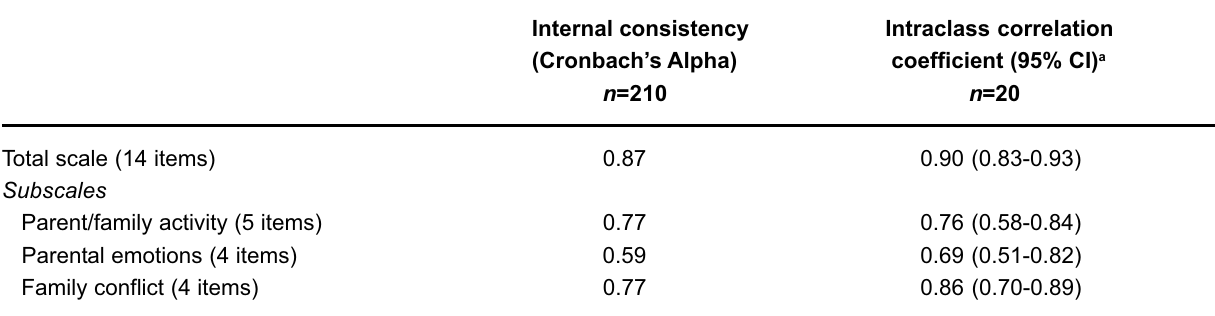
One-way random effect parallel model: a p < 0.001 for all